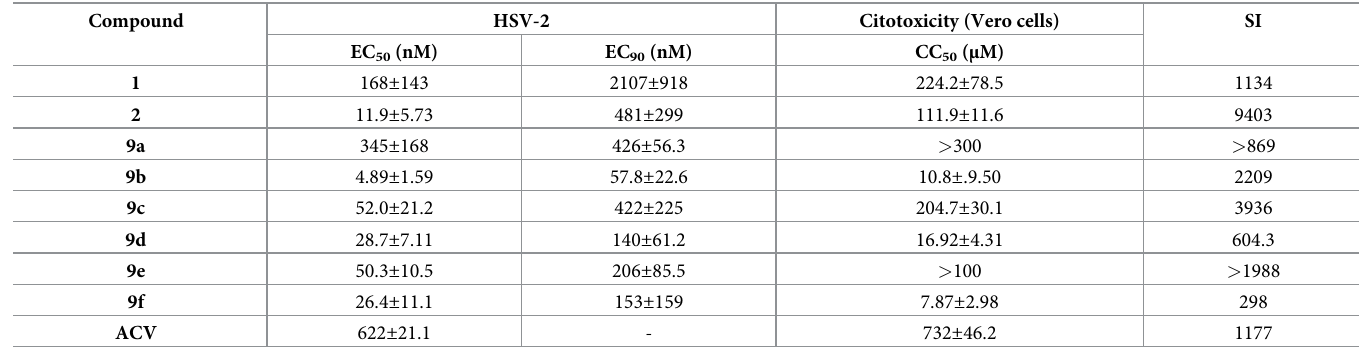
Table 2. Antiviral activity of the rhodanine derivatives on Vero cell line infected with HSV-2. Compound